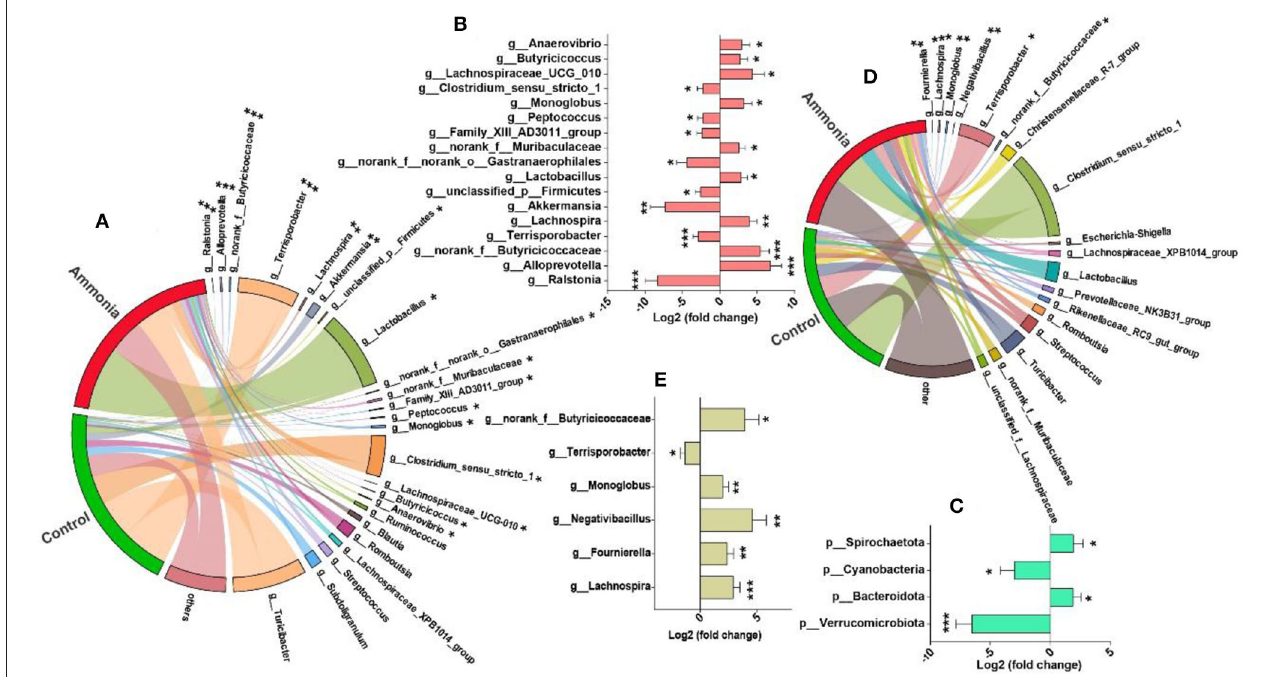
FIGURE 4 | Differentially abundant genera from the cecum or colon after ammonia exposure. The mainly enriched genera (including differentially abundant genera) from (A) the cecum or (D) colon in control group vs. ammonia group; the differentially abundant (B) genera or (C) phyla from the cecum and the differentially abundant (E) genera from the colon after high ammonia exposure. *FDR < 0.05, **FDR < 0.01, and ***FDR < 0.001,